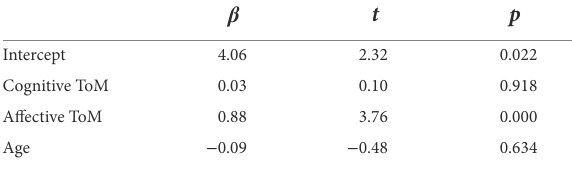
TABLE 4 Results of the multiple linear regression of the total score in persuasion (response variable) and the cognitive ToM and affective ToM dimensions (independent variables), the covariate being the age